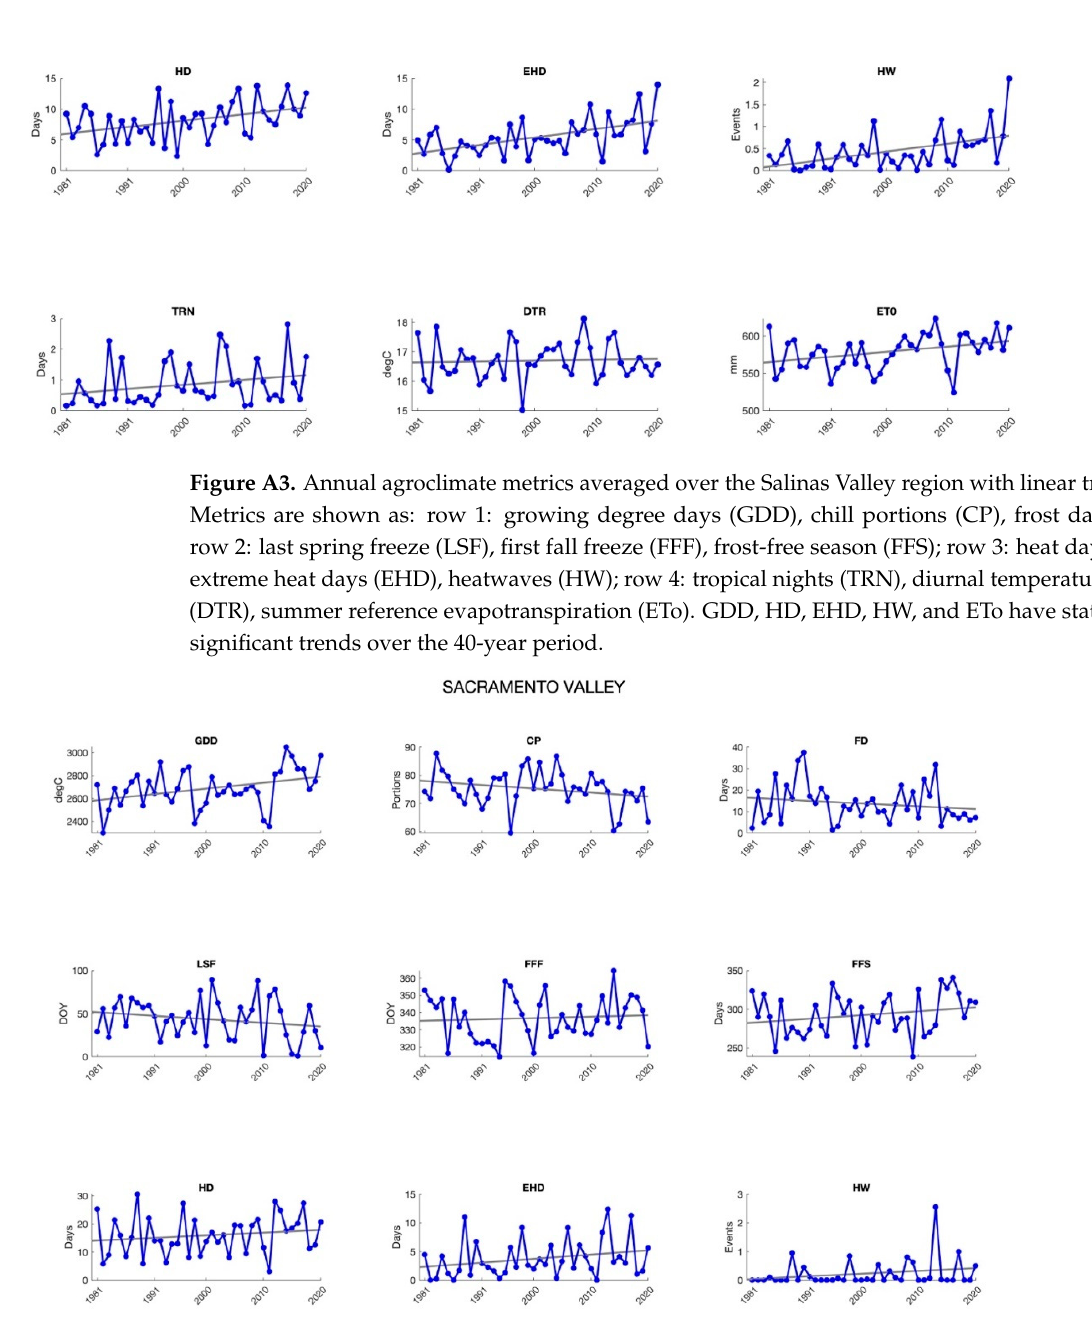
17 of 24 Figure A2. Annual agroclimate metrics averaged over the Central Coast region with linear trend- line. Metrics are shown as: row 1: growing degree days (GDD), chill portions (CP), frost days (FD); row 2: last spring freeze (LSF), first fall freeze (FFF), frost-free season (FFS); row 3: heat days (HD), extreme heat days (EHD), heatwaves (HW); row 4: tropical nights (TRN), diurnal temperature range (DTR), summer reference evapotranspiration (ETo). GDD, HD, EHD, HW, and TRN have statisti- cally significant trends over the 40-year period.